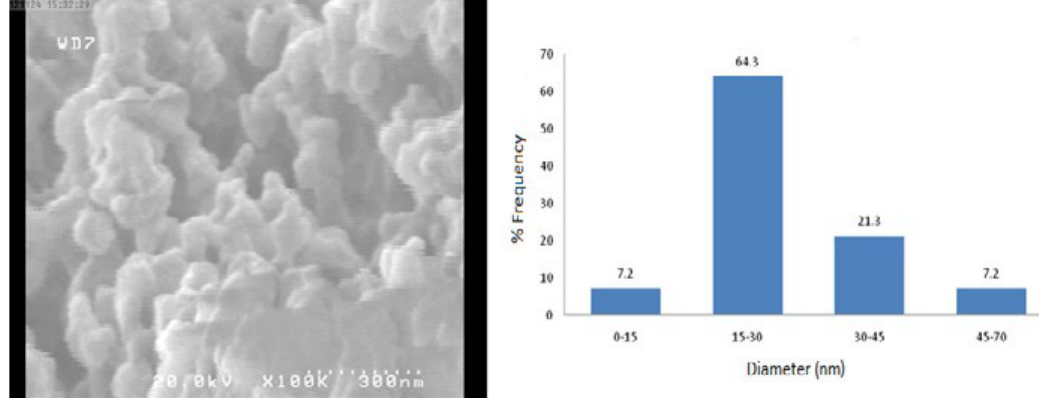
Fig. 11. SEM image and the corresponding particle size distribution histogram of CuO nano-particles prepared by calcination of nano-powder of compound 1 at 450